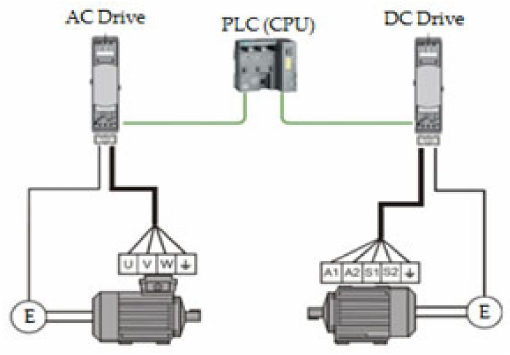
Figure 8. The electric motors control